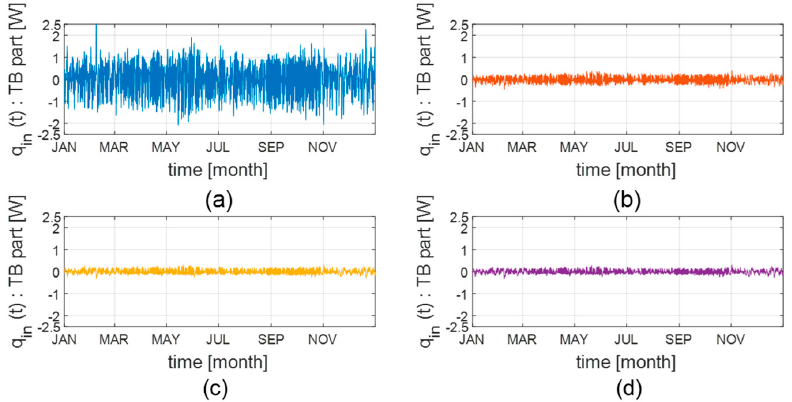
Figure 12. Residual of the heat flow rate: ( a ) First-Order model; ( b ) Second-Order model; ( c ) Third-Order model; ( d ) Fourth-Order model. Table 8. System response RMSE of each model for the annual outdoor temperature.